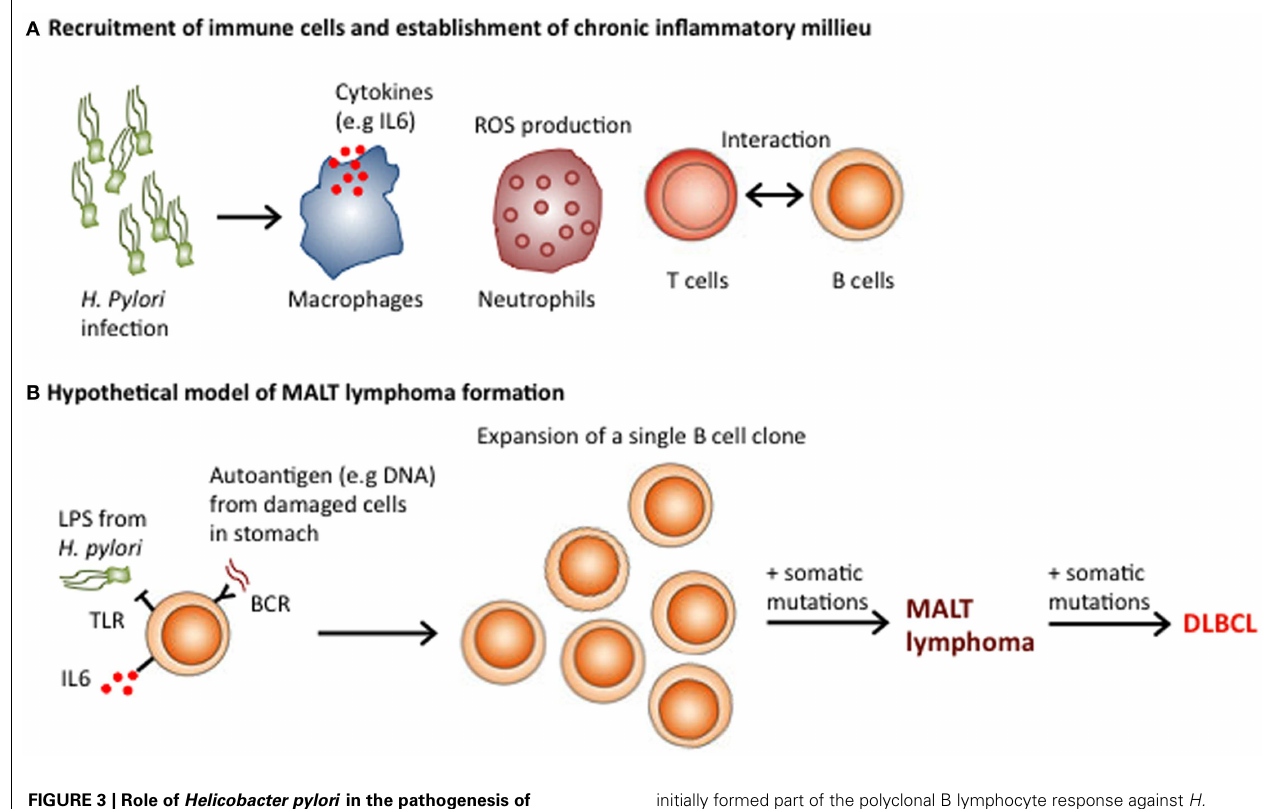
FIGURE 3 | Role of Helicobacter pylori in the pathogenesis of gastric MALT lymphoma . (A) H. pylori infection results in buffering of the gastric pH, which allows immune cell infiltration and the establishment of MALT.The presentation of H. pylori antigens by dendritic cells recruits and activatesT cell responses, which enhance B cell activation through CD40–CD40L interactions. (B) MALT lymphoma may result from the transformation of a single B cell clone, which